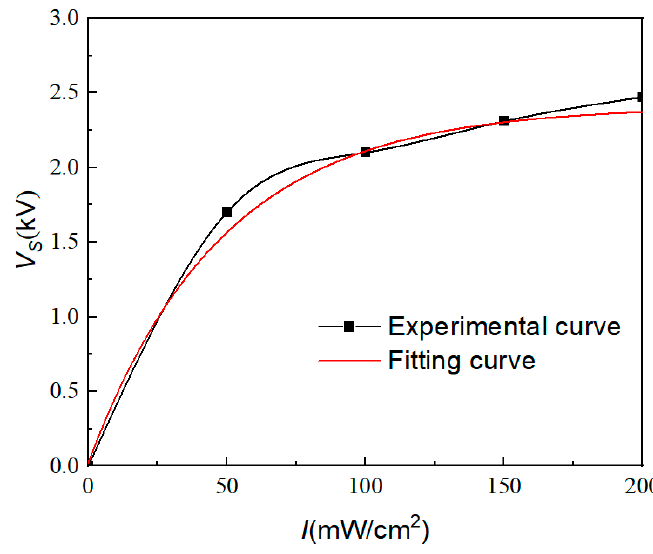
Figure 4. Relationship between light intensity and photovoltage.